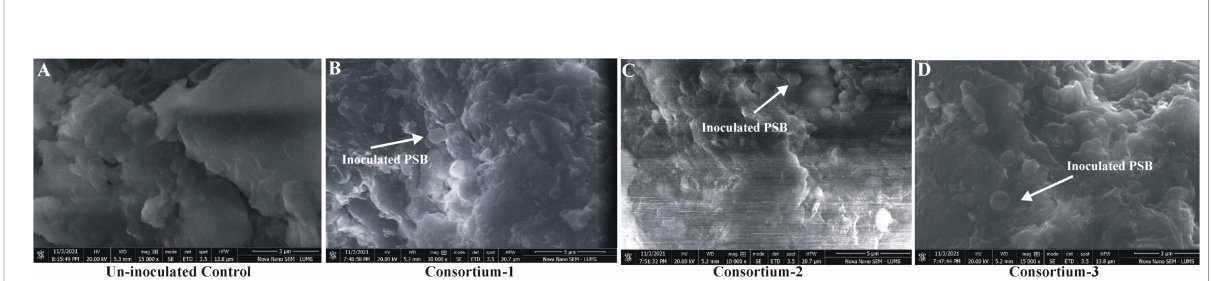
FIGURE 2 Shelf life study of fi lter mud-based formulation inoculated with soil-speci fi c consortia under controlled conditions. Field emission scanning electron microscopic (FESEM) analysis of uninoculated fi lter mud-based bioformulations (A) and inoculated fi lter mud-based bioformulations with consortium-1 (B) , consortium-2 (C) , and consortium-3 (D) .